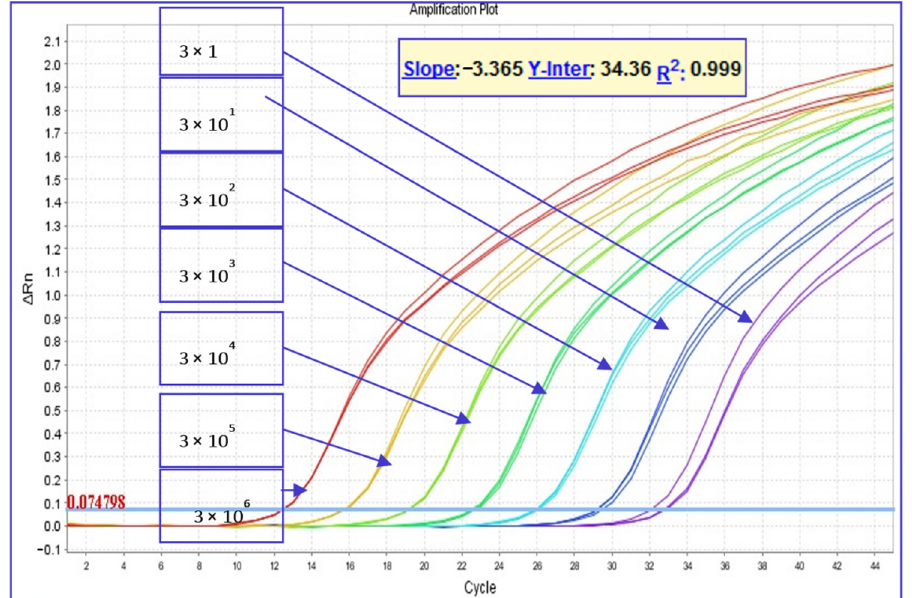
Figure 1. Amplification plot of the P. larvae genome standard curve. Relation between serial dilutions of DNA from P. larvae ATCC 9545 and the threshold cycle (Ct). The Ct values increased in proportion to initial DNA template quantities at a range from 0.3 to 3 × 10 6 genome copies. Standard curves showed values of efficiency and linearity of the reaction (slope = − 3.365; R 2 = 0.999).